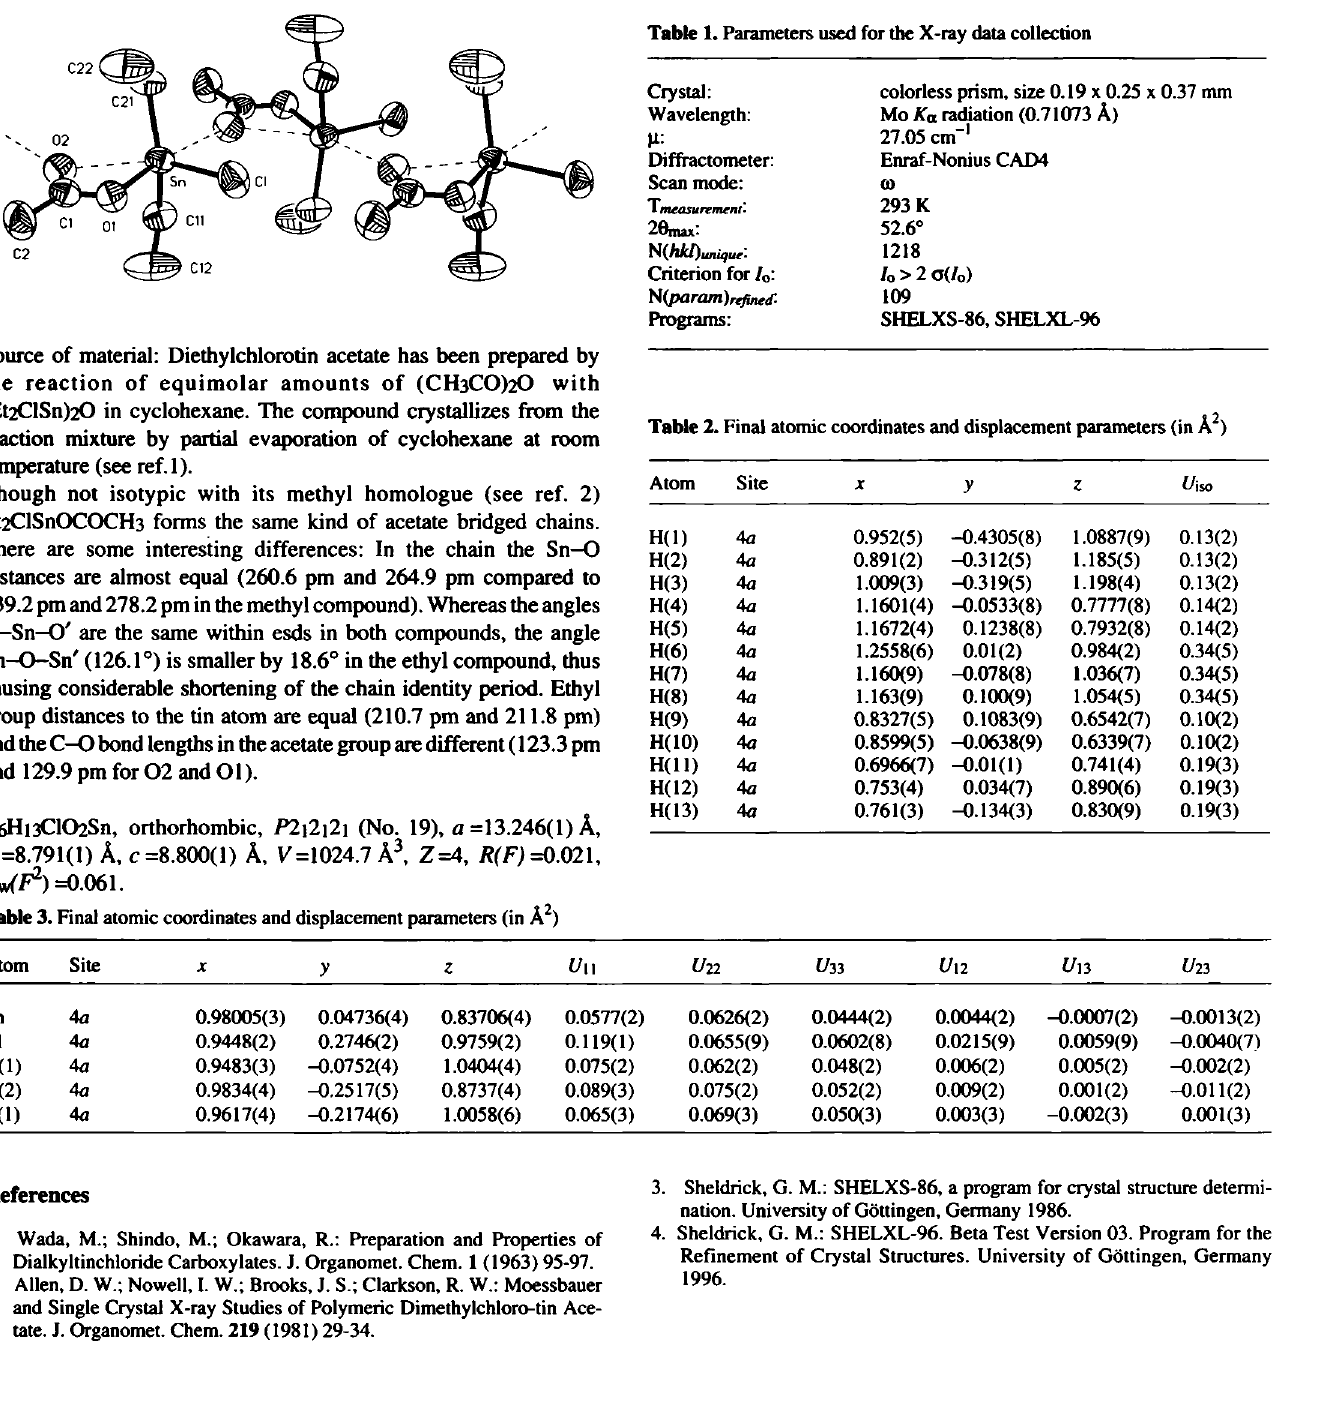
Table 1. Parameters used for the X-ray data collection Crystal: